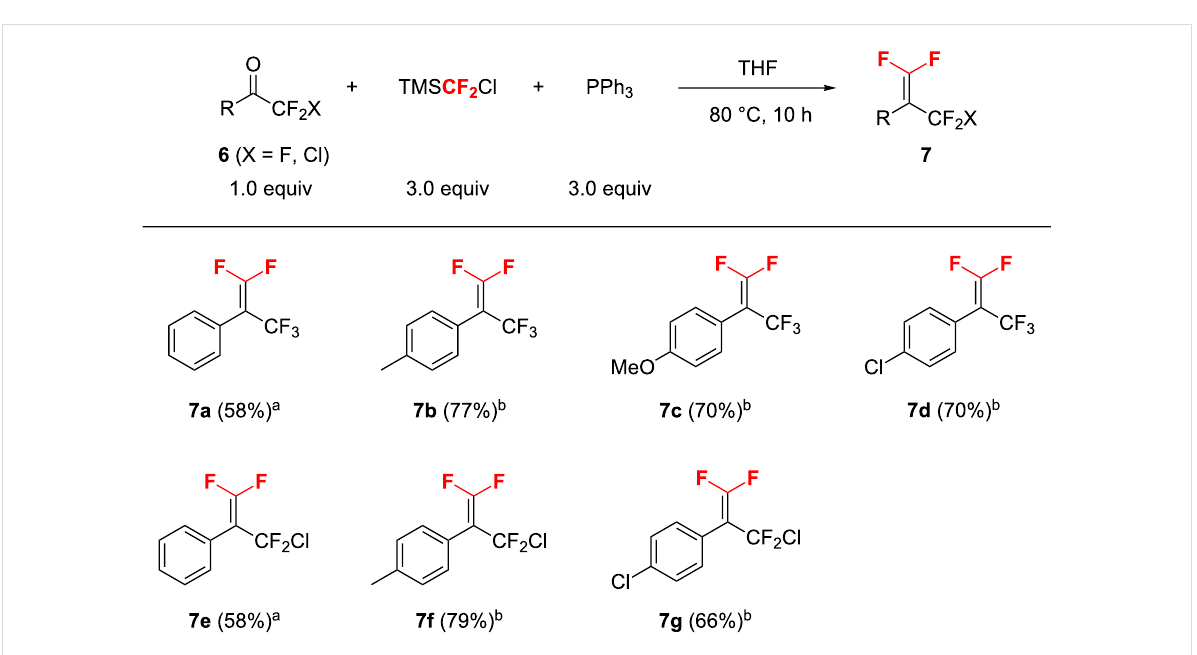
Figure 2: gem -Difluoroolefination of activated ketones. Reactions were performed on 0.5 mmol scale in a pressure tube. a Yield was determined by 19 F NMR spectroscopy using PhCF 3 as an internal standard. b Isolated